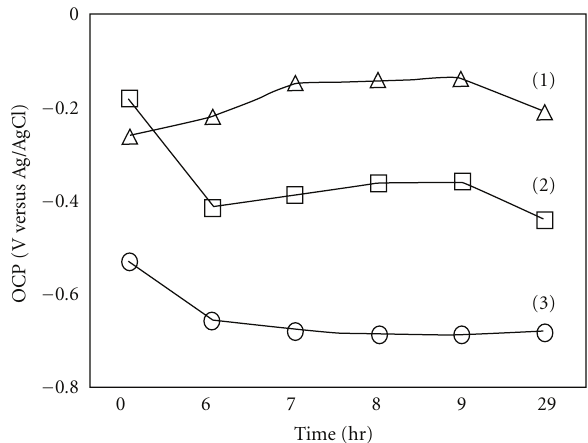
Figure 2: Variation of the open circuit potential with time: (1) Na 2 MoO 4 :NaNO 2 180 :75 ppm; (2) Na 2 MoO 4 180ppm; (3) RO